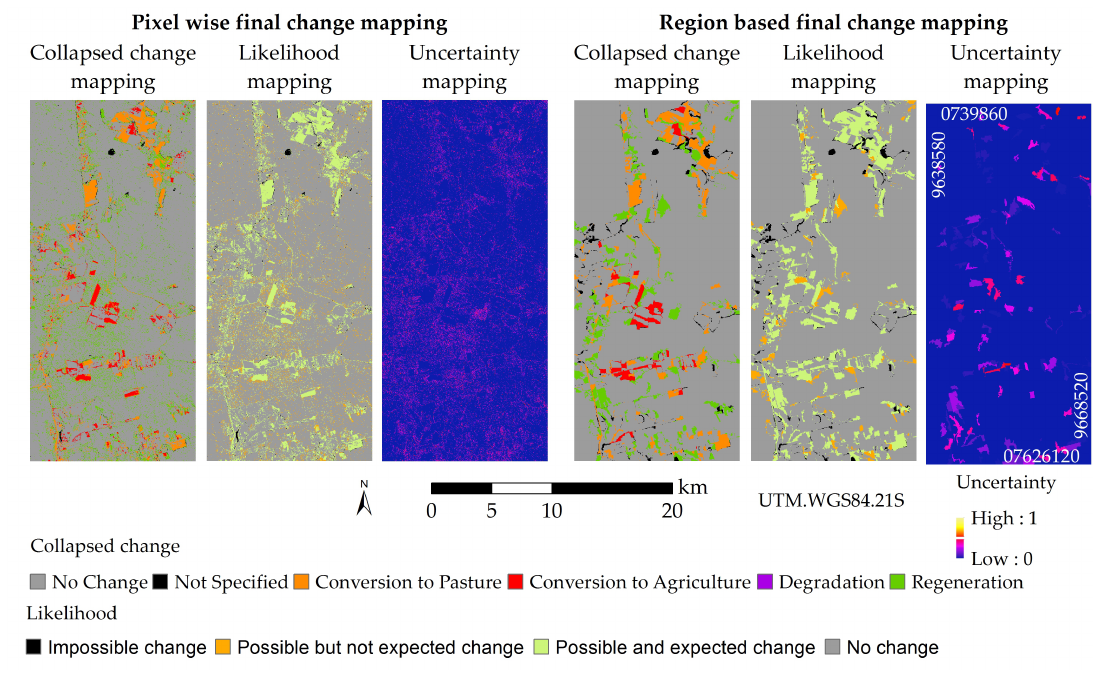
Figure 13. Final change mapping and associated quality mappings for L2